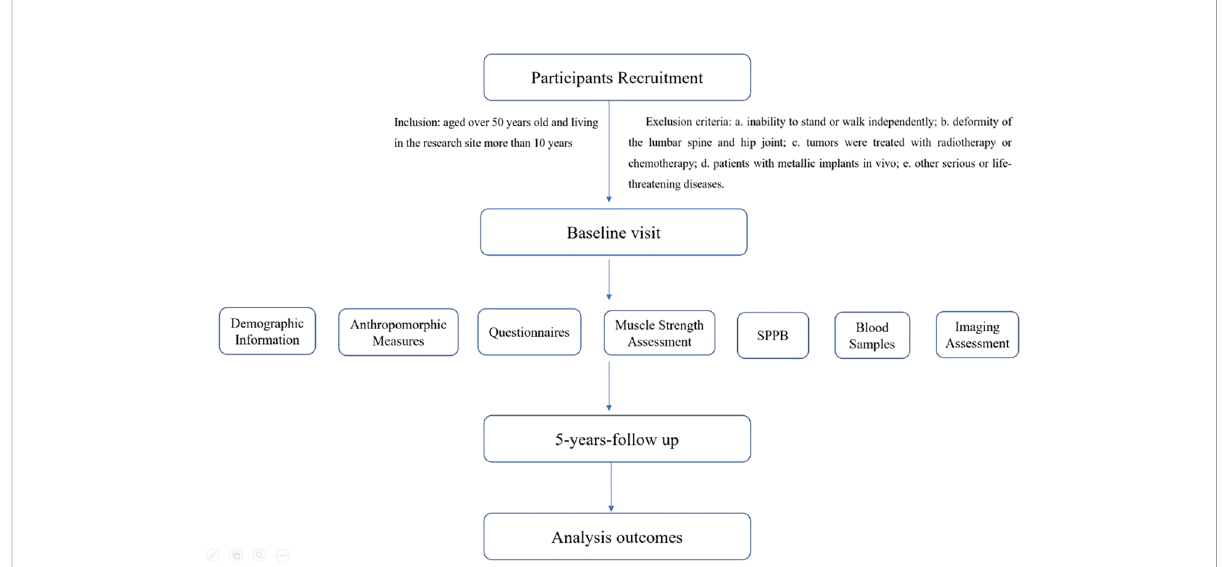
FIGURE 1 Flow chart of study design and procedures. SPPB, short physical performance battery. The analysis outcomes included: the changes in muscle size, density, and fat in fi ltration in different muscles, the decrease in BMD, the muscle function impairment, and the osteoporotic fracture incidence during a fi ve-year follow-up